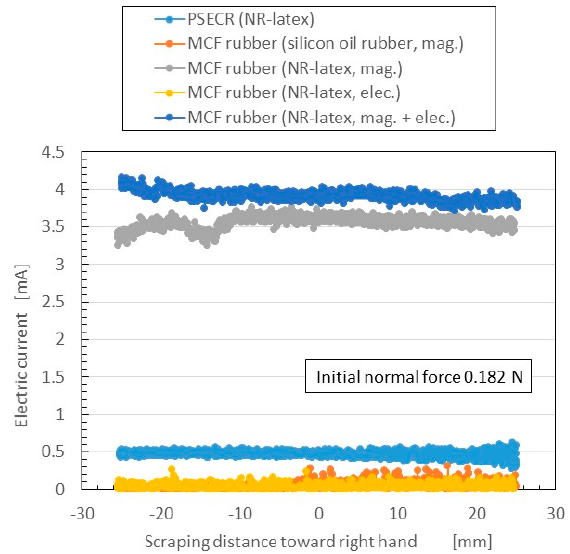
Figure 10. Electrical characteristics of MCF rubber made by the new method in the case of SFE, comparing among three electric and magnetic field condition, and among NR-latex, silicon oil, and PSECR rubber.